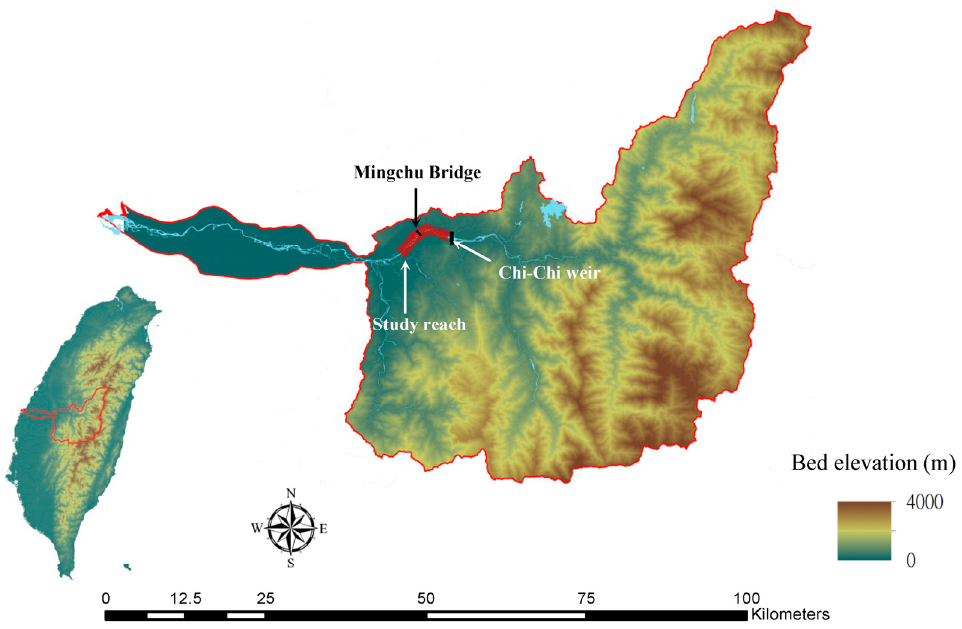
Figure 1. Map of Cho-Shui River basin in Taiwan, showing the location of the study.